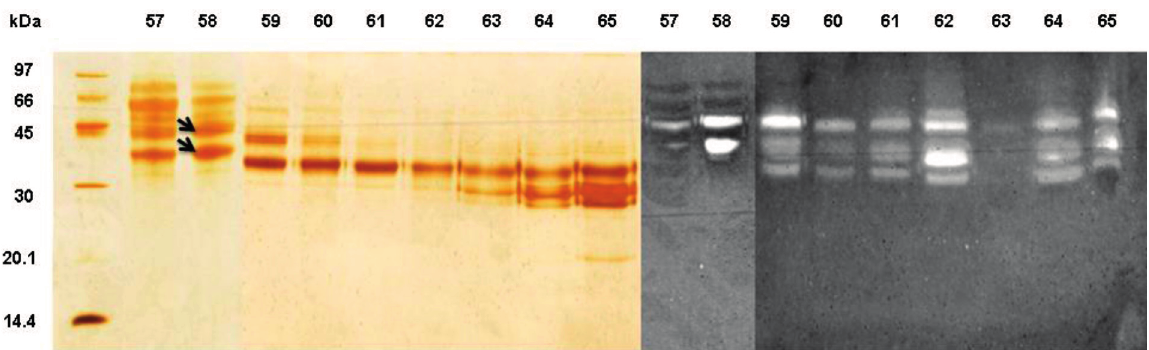
Figure 2. Elution profile of Man 58 on Sephacryl S-100 chromatography.